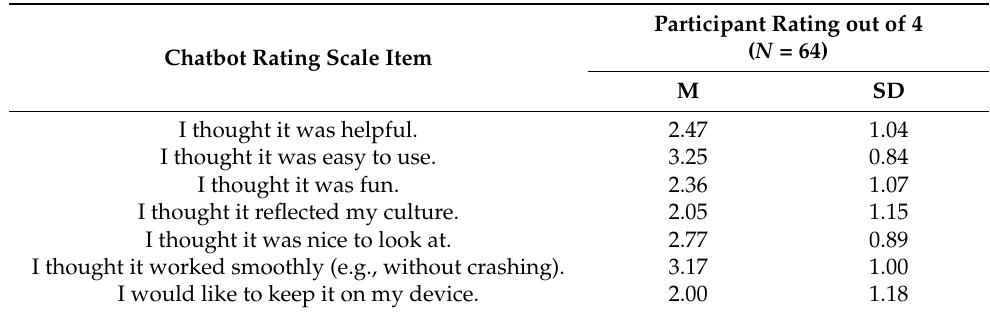
Table 5. Mean ratings on the Chatbot Rating Scale [range between 0 (not at all) to 4 (definitely) collected at post-intervention (day 22).